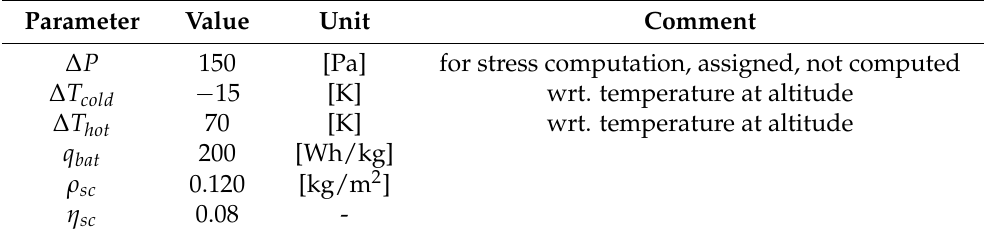
Table 3. Parameters assigned specifically for the validation on the